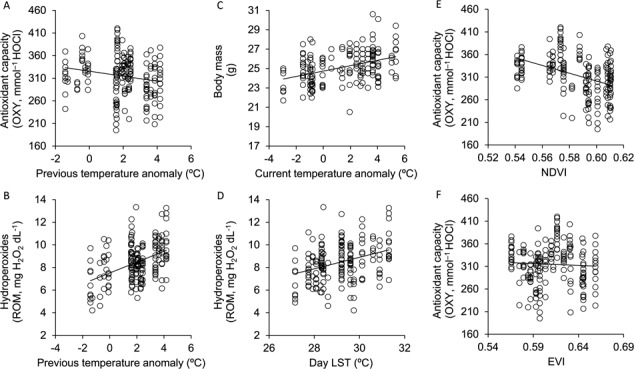
Significant relationships between environmental conditions (x-axis) and physiological parameters (y-axis). Raw data are presented. Statistical results are presented in Table 4.